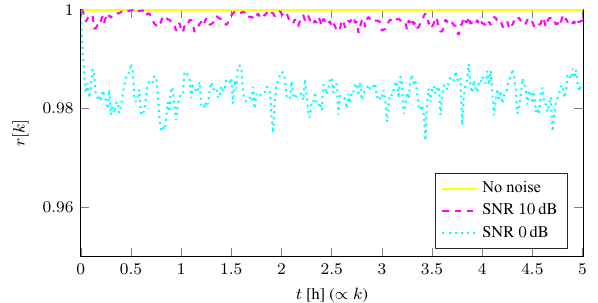
Figure 10. Reliability and detected defects for peak sensor faults. Peaks are randomly inserted to the measurement with frequencies from 1 to 10 peaks per minute by adding 100 ◦ C to the original sensor readings. The detected defect is marked by a red dot.